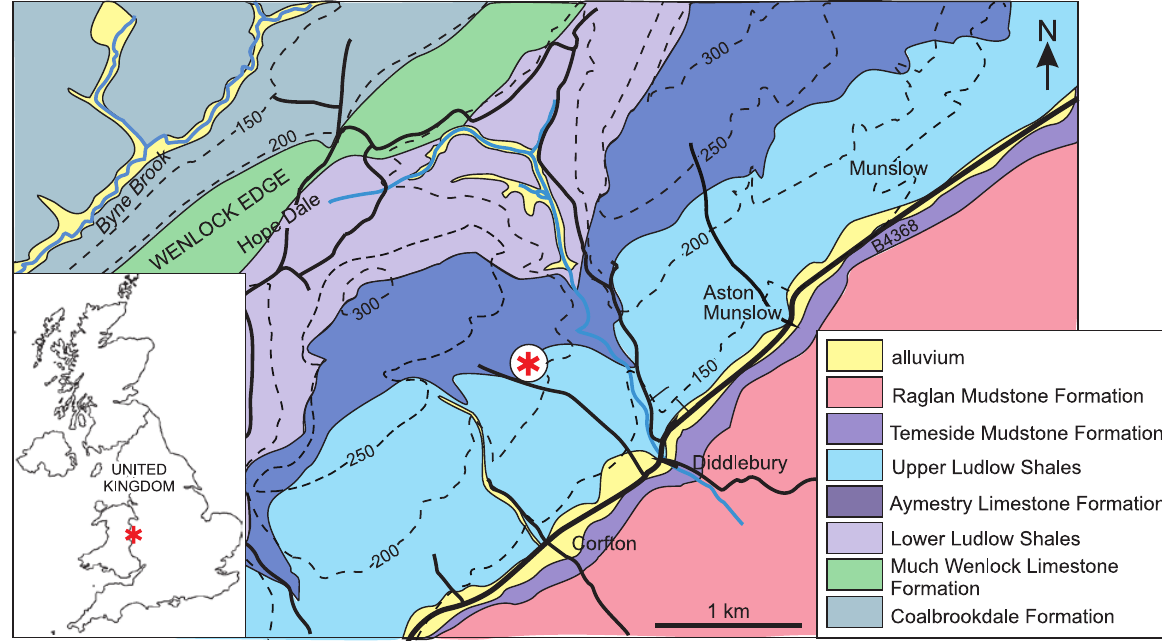
Fig. 1. Map showing the location and geological setting (asterisk) of Delbury Quarry in Shropshire, UK (amended from https://digimap.edina.ac.uk/roam/ map/geology and https://digimap.edina.ac.uk/roam/map/os; accessed 05/08/21).